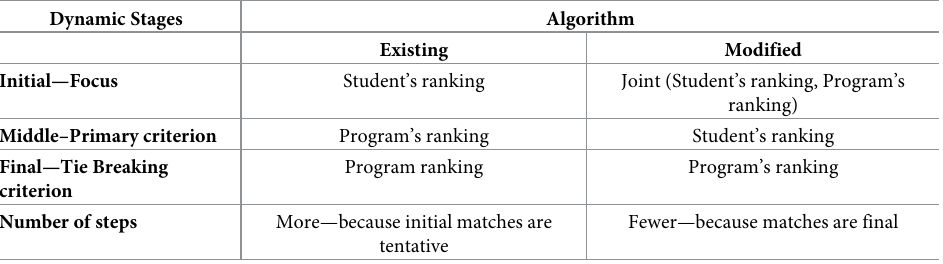
Table 4. Increasing algorithm’s responsiveness to multiple stakeholders (programs and